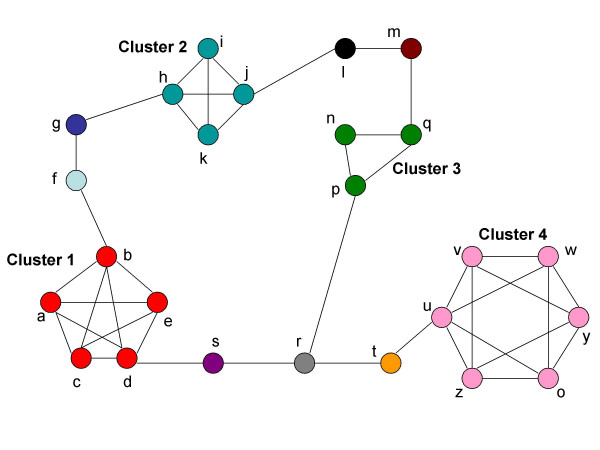
Example of a network characterized by a number of clusters. The length of the links does not reflect distances or connection strengths. All of the direct connections are considered equally.